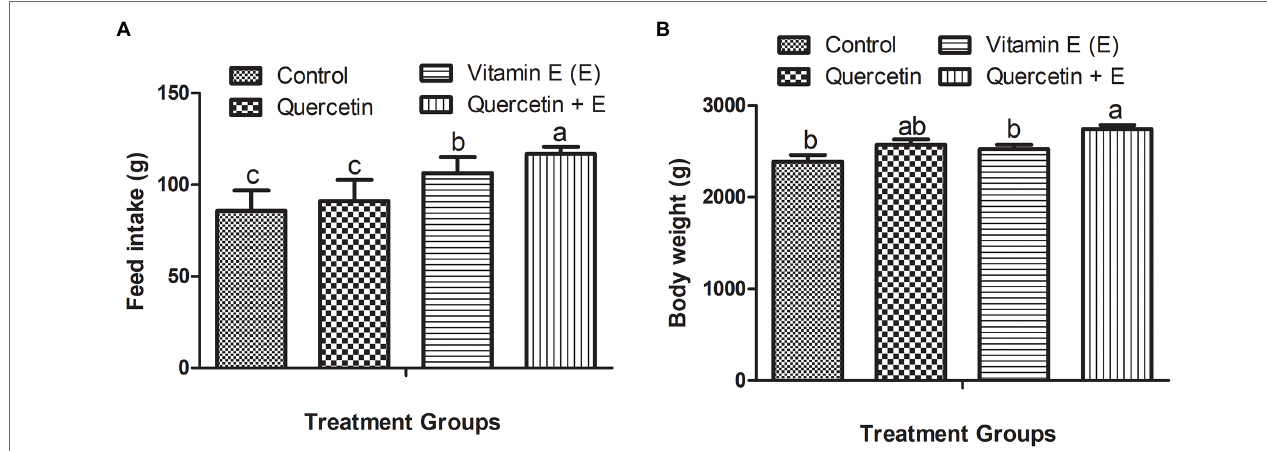
FIGURE 1 | Impacts of dietary quercetin, vitamin E, and the combination of quercetin and vitamin E on the feed intake and body weight of aged broiler breeder hens. Bars without the same letter differed significantly ( p < 0.05). (A) Feed intake; (B) body weight.